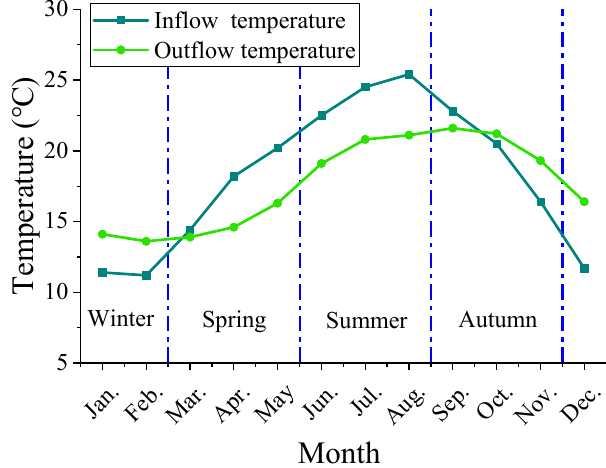
Figure 3. Upstream of hydropower station dam. Table 1. Basic parameters of the deep water reservoir.